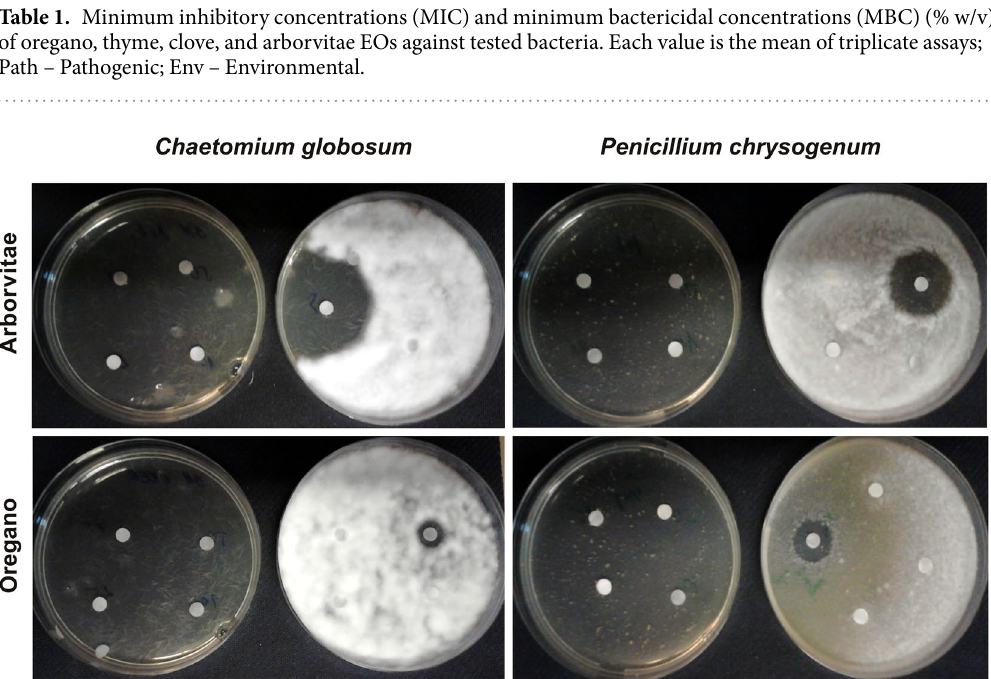
Figure 2. Antifungal activity of arborvitae and oregano EOs against Chaetomium globosum and Penicilium chrysogenum . The effects of different concentrations (75%, 50%, 25%, 10% – left plates and 5% – right plates) of EOs dissolved in DMSO are shown. The disc-diffusion assay reveals total growth inhibition after treatment with 75%, 50%, 25%, and 10% (w/v)